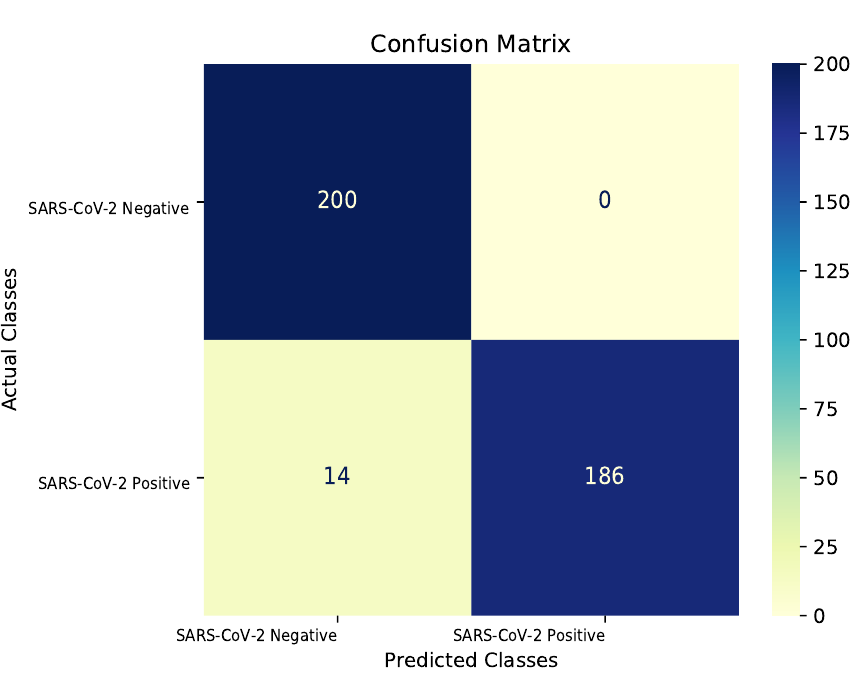
Figure 6. Confusion matrix for COVID-19 detection using Bit-M fine-tuning model. Color bar indicates intensity of